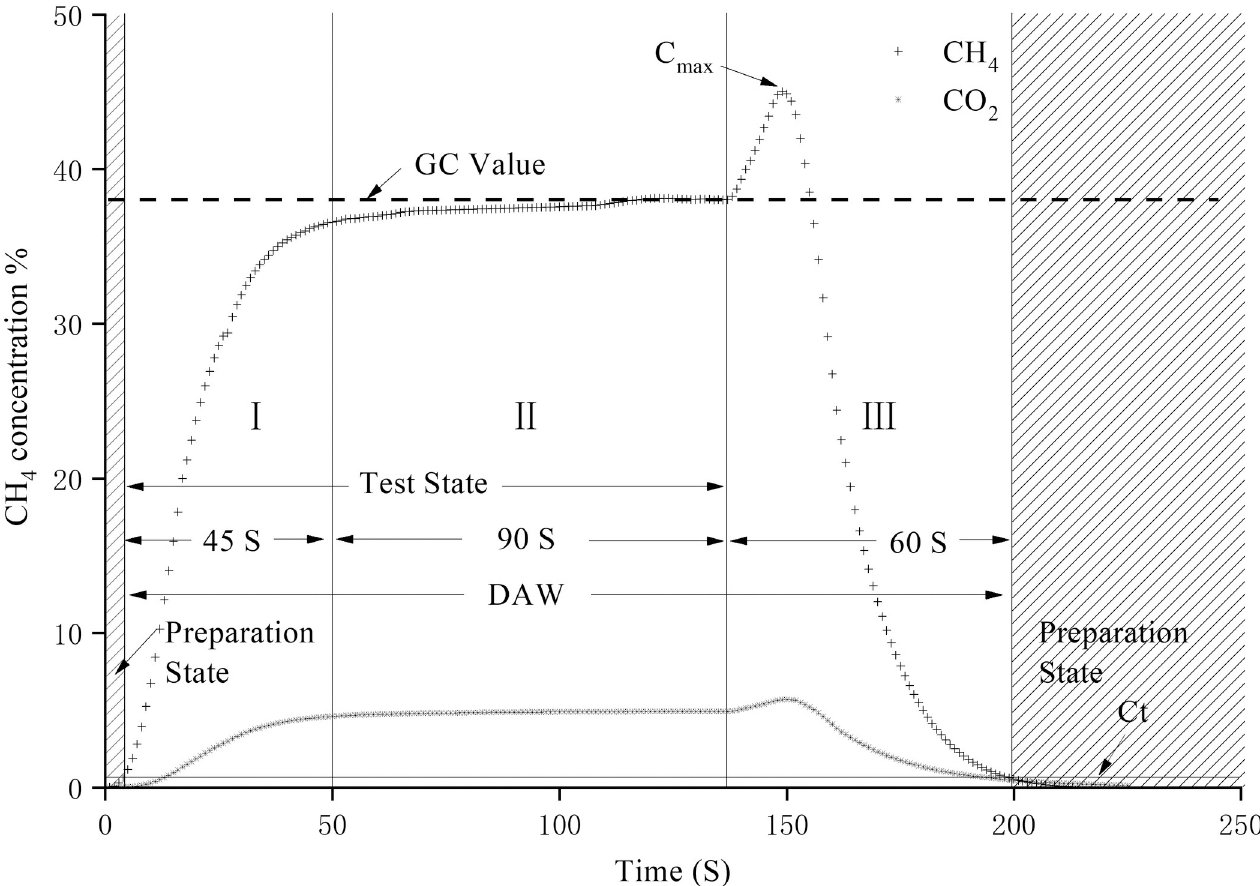
Fig 1. Gas concentration curve in one monitoring window. The test process was divided into three stages based on the test method and gas concentration change factors. Ct is the threshold value.